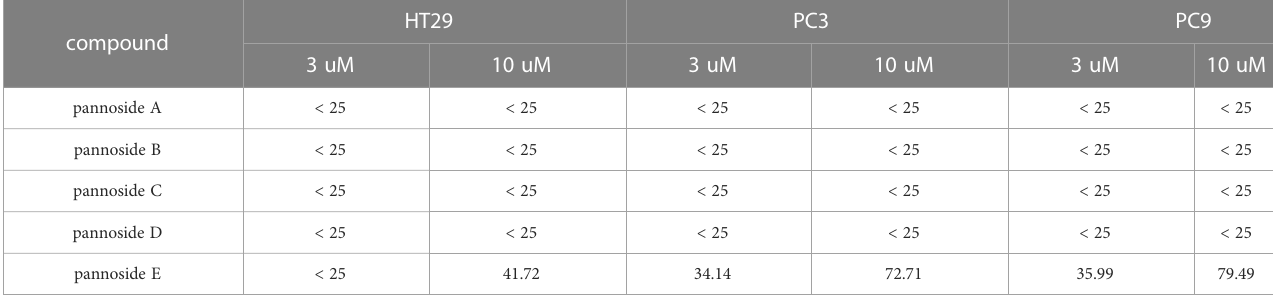
% cell inhibition,